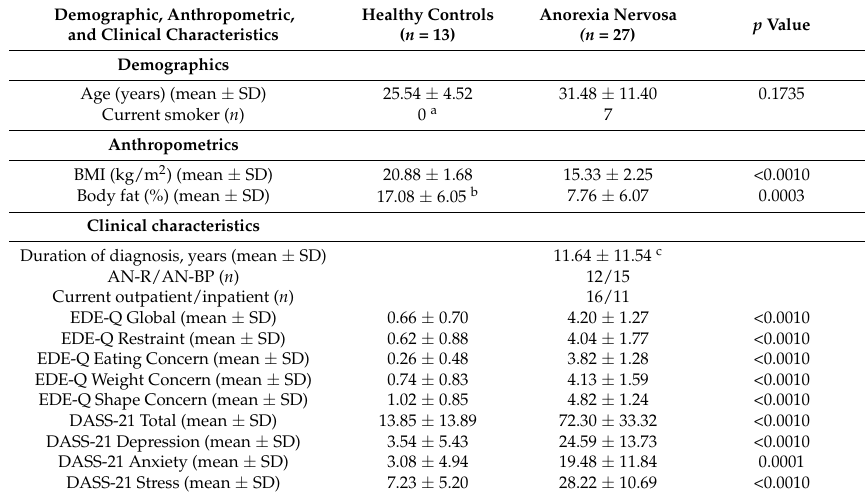
Table 1. Demographic, anthropometric, and clinical characteristics for AN participants and HCs. Demographic, Anthropometric, and Clinical